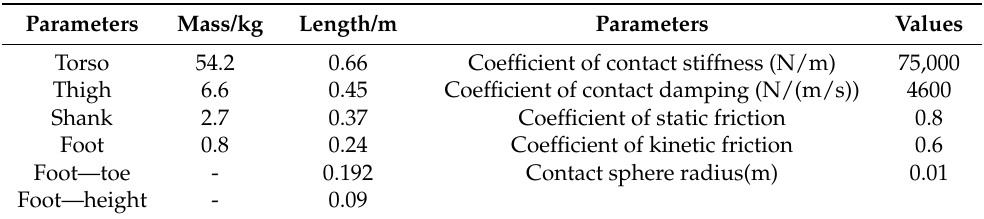
Figure 1. Simulation model of a bipedal robot. Table 1. Model